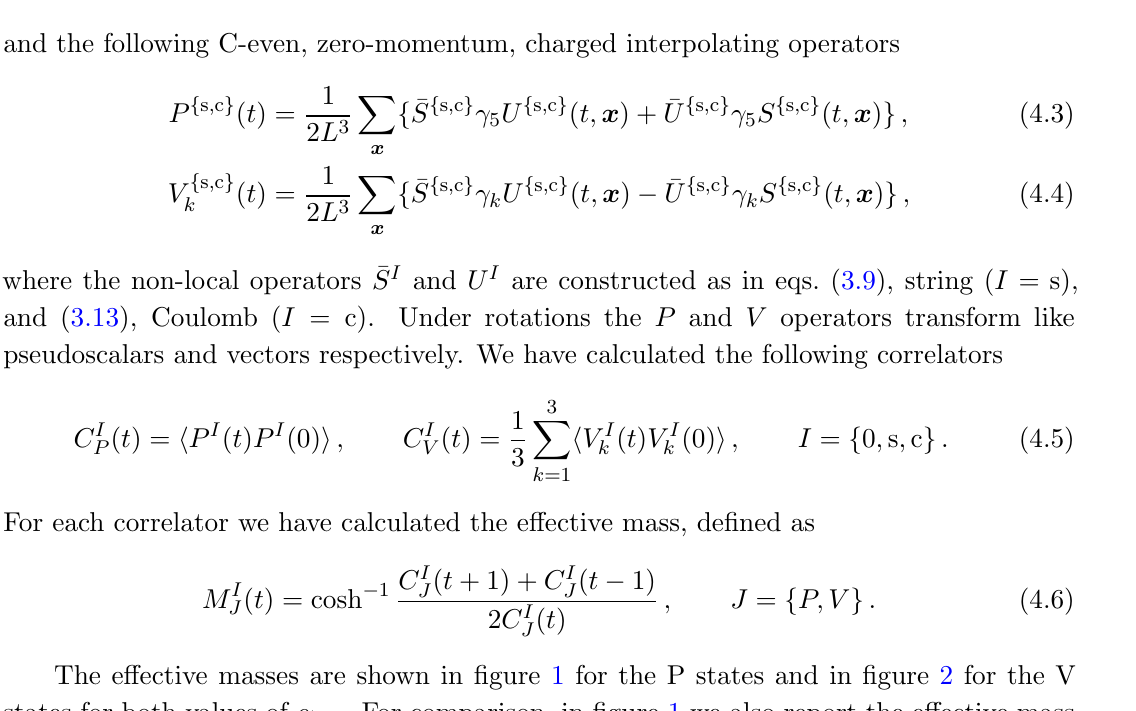
Figure 1 . Effective masses for the pseudoscalar correlators at α em = 0 . 05 (left plot, blue and orange points), α em = 1 / 137 (right plot, blue and orange points), and α em = 0 (both plots, green points). The blue points correspond to the neutral states, M 0 the charged states interpolated by using either the string, M s The green points correspond to the states in QCD-only simulations, M qcd numerical signal is essentially the same for charged and neutral states, with and without QED, and it is not affected by the non-local gauge-invariant operators used in the charged channel. With these unphysical values of the bare parameters the charged-neutral mass splitting can be extracted with statistical significance even at α em = 1 /